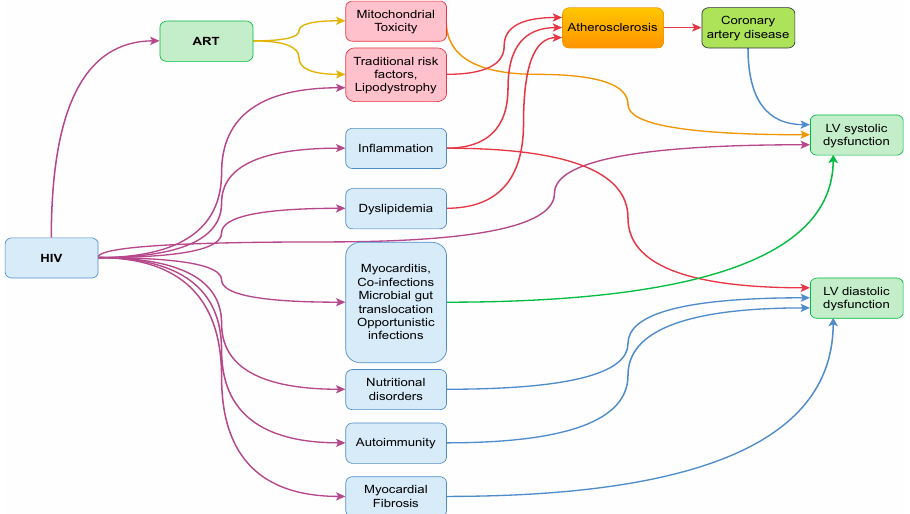
Figure 3. Proposed mechanisms of systolic and diastolic cardiac dysfunction in HIV-infected persons. ART = Antiretroviral therapy; LV = left ventricular.